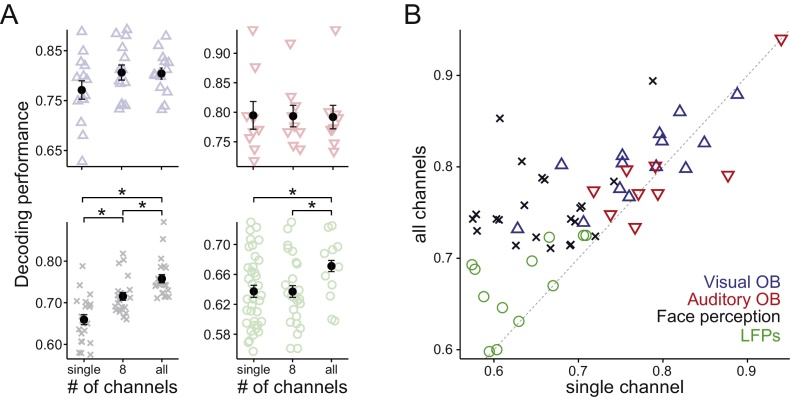
Performance of decoding with simultaneous channels. (A) Each panel shows decoding performance obtained when one, eight or all channels are used. Light marks show individual performances. Dark filled circles denote average performance and bars indicate SEM. No comparison was significant in both visual and auditory oddball datasets (p > .05). All comparisons in the face perception experiment were significant (paired sign tests, p ∼ 10−4, p ∼ 10−4, p ∼ 10−4, for single vs 8, single vs all, 8 vs all channels, respectively). For the LFP dataset, only single vs 8 and 8 vs all channels were significantly different (paired sign tests, p = 0.012 and p = 6.3 × 10−3, respectively; see text for details on how LFP performances were paired). Color codes are same as in B. (B) Performance of all sessions/responses from all datasets when a single channel (horizontal axis) or all channels (vertical axis) were used.